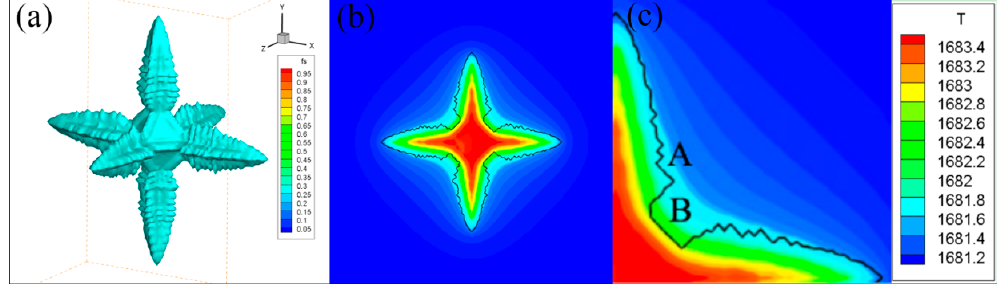
Figure 7. ( a ) Three-dimensional facet dendrite, ( b ) temperature field and solid-liquid interface morphology and ( c ) quarter enlarged view of dendrite.